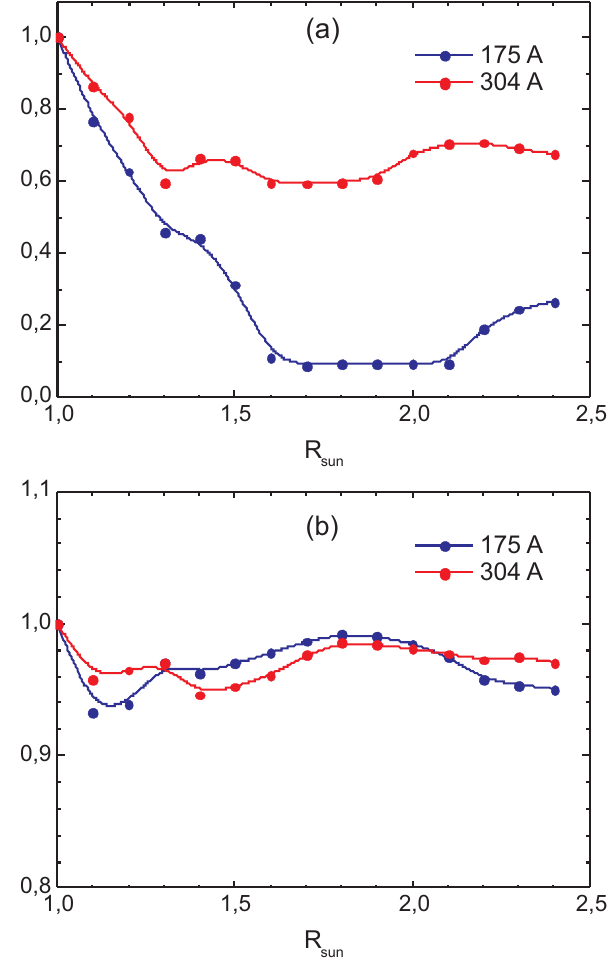
Fig. 8. (a) Cross-correlation between the latitudinal brightness dis- tributions for different distances in the west corona and the limb distributions in the SPIRIT 175 and 304 ˚A bands for 16 June 2002; (b) cross-correlation of the temporal brightness variations at differ- ent heights along the west equatorial line with that at the underlying limb region during a week of 16 June 2002–22 June 2002.